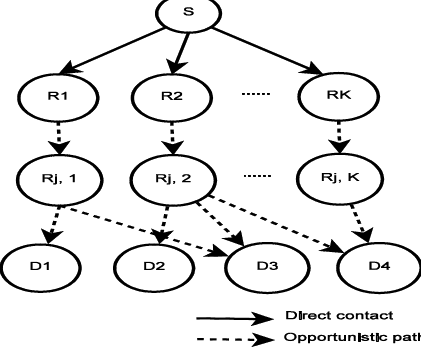
Figure 5. The SDM data forwarding process [34].